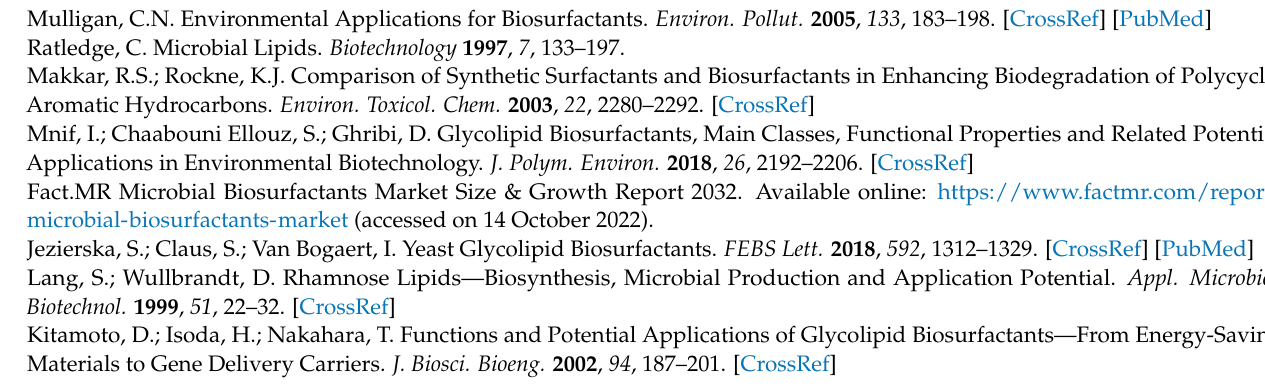
Table S1: Experimental values of MEL, residual lipids rejection (%) and flux (L/m 2 /h/bar) for each membrane tested using EtOAc or MeOH as organic solvents. For each membrane, we also calculated the theoretical minimum DV and the corresponding MEL losses (%) to achieve 97% of